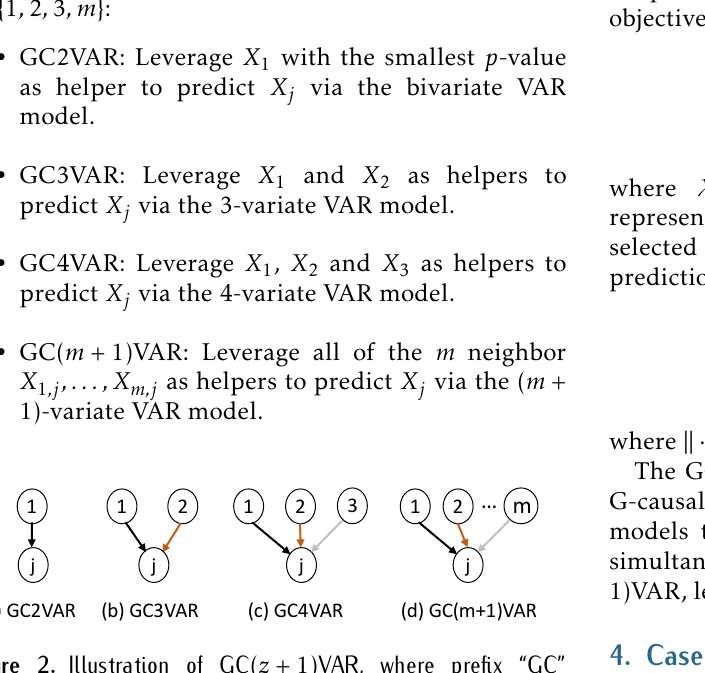
≤ p ≤ . . . ≤ p 1 ,j 2 ,j m,j